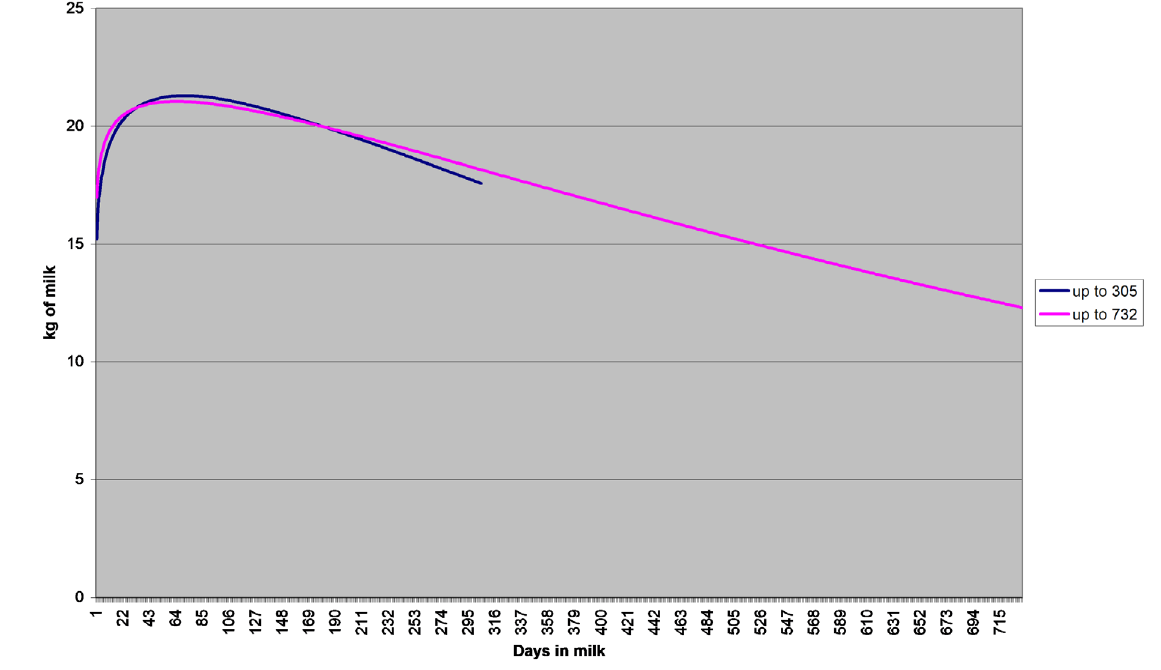
Figure 4. Shape of lactation curve according to the length of lactation (amount of information). Shorter curve indicates average daily milk yield up to 305 days of lactation and longer curve up to 732 days of